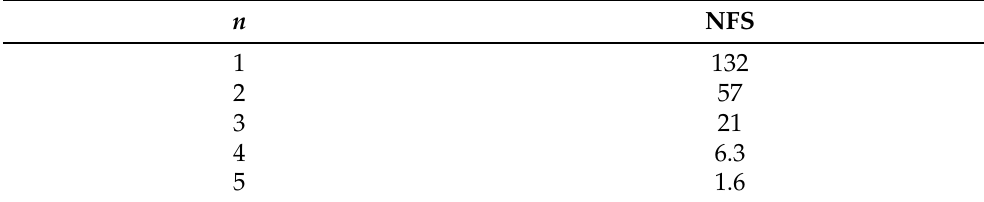
Table 1. p-Ta at 27.5 GeV.